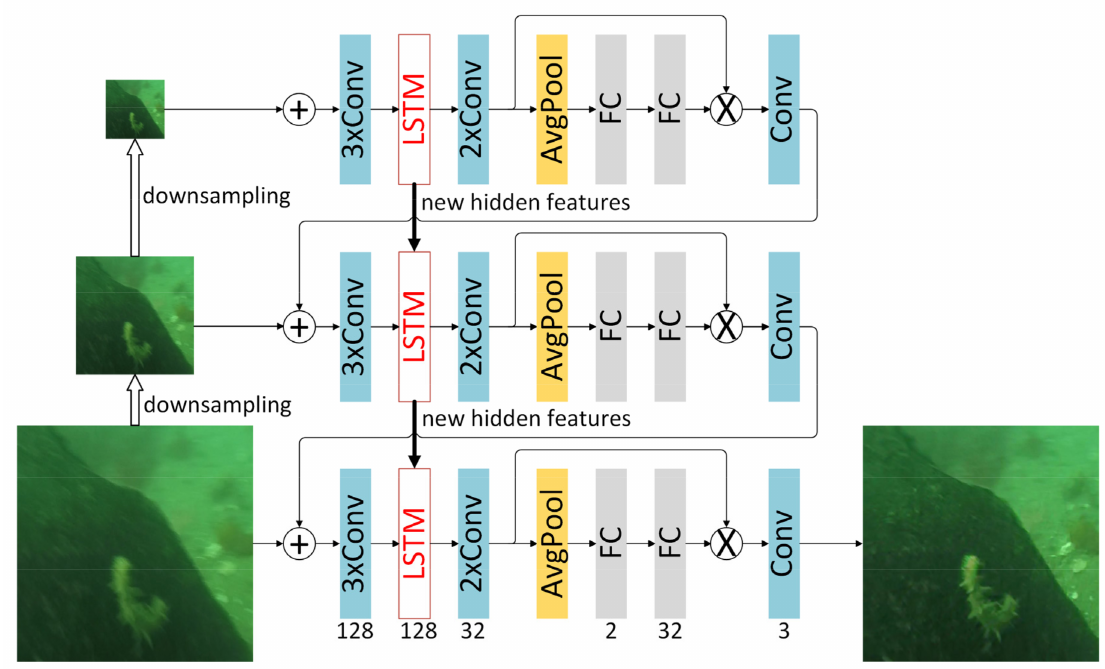
Figure 4. The diagram of the multiscale-based deblurring